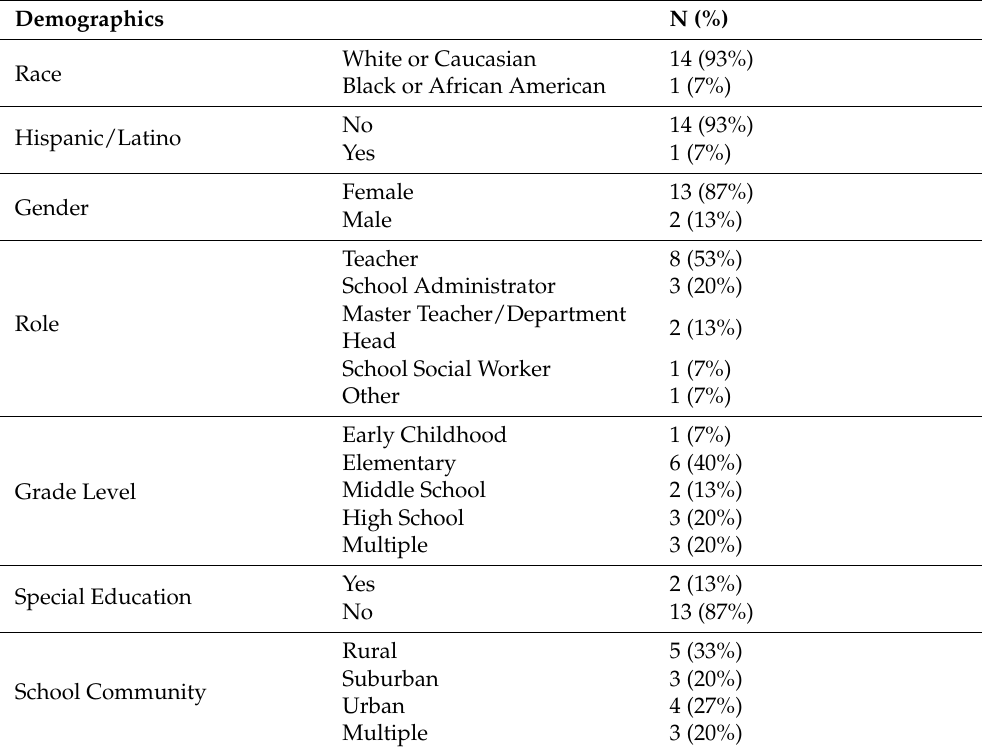
Table 1. Focus group participant